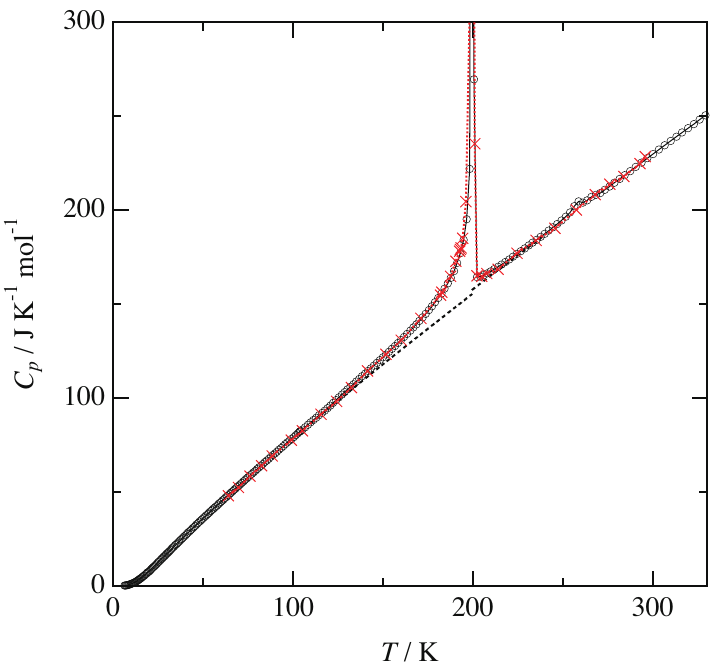
Figure 2. Experimental heat capacities of crystalline sorbose. Black circle, present data for D -sorbose; red cross, data for L -sorbose by Jack and Stegeman [7]; dotted line, normal heat capacity (see the